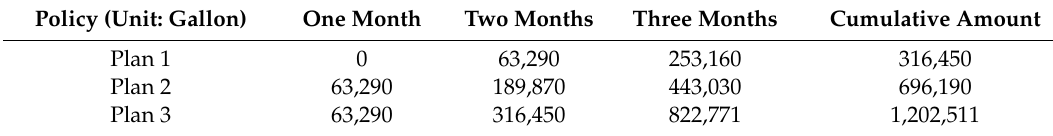
Table 3. Quantity of available water for drought mitigation.